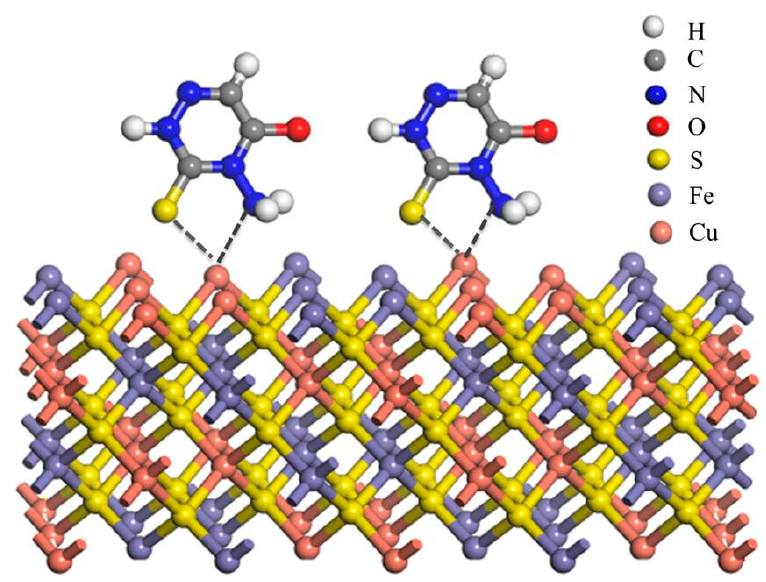
Figure 12. The proposed adsorption models of ATDT on chalcopyrite surface.